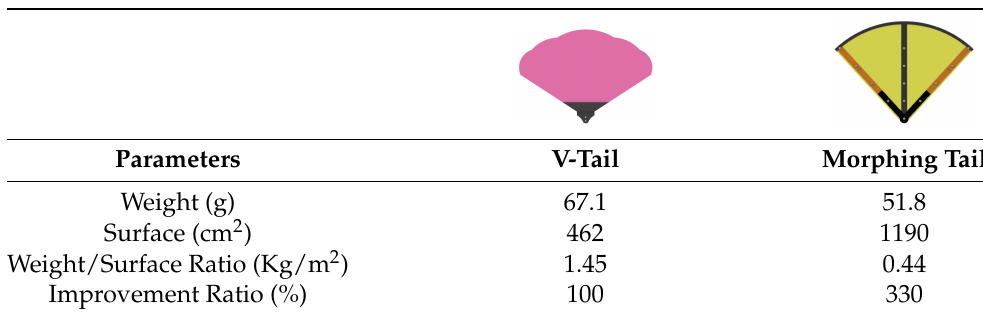
Table 2. Weight/Surface Tails